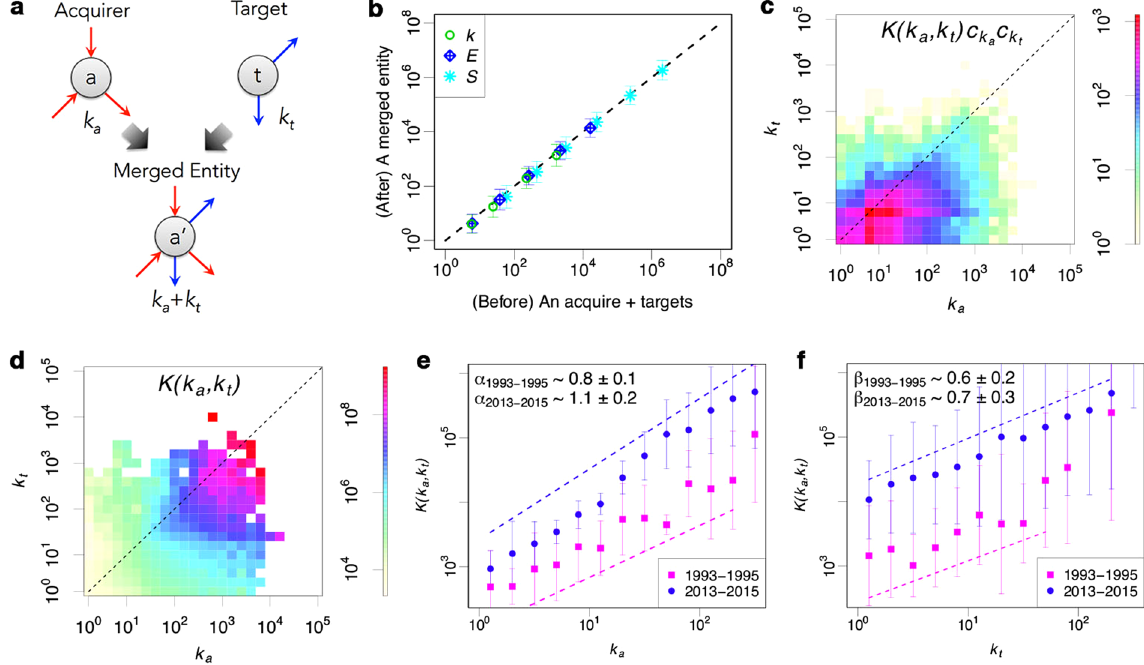
Figure 2. Statistical characteristics of M&A activities. ( a ) A schematic figure showing a merger event. ( b ) The relation between a size of merged entity and summation of sizes of an acquirer firm and target firms in 2014. Green circles, blue rhombuses and light blue asterisks show the mean number of transactions k , number of employees E and sales (million yen) S , respectively. ( c , d ) Heatmap showing the frequency and probability of M&A between an acquirer firm of size k a and its target of size k t based on the data from 1994 to 2014. ( e , f ) K ( k a , k t )’s scaling laws with respect to k a and k t , respectively. Pink squares and blue circles show the relation between the mean of K ( k a , k t ) and k a or k t with fixed k t or k a from 1993 to 1995 and from 2013 to 2015 in log-log scale, respectively. Each equally color coded dashed-line shows a slope of α and β